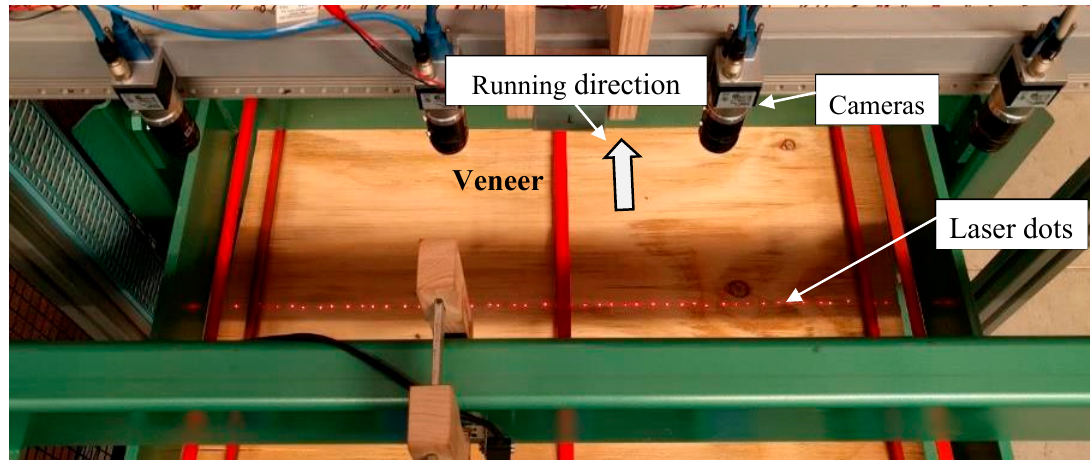
Figure 2. Picture of the local online orientation fiber analyzer (LOOBAR) laser scanner.